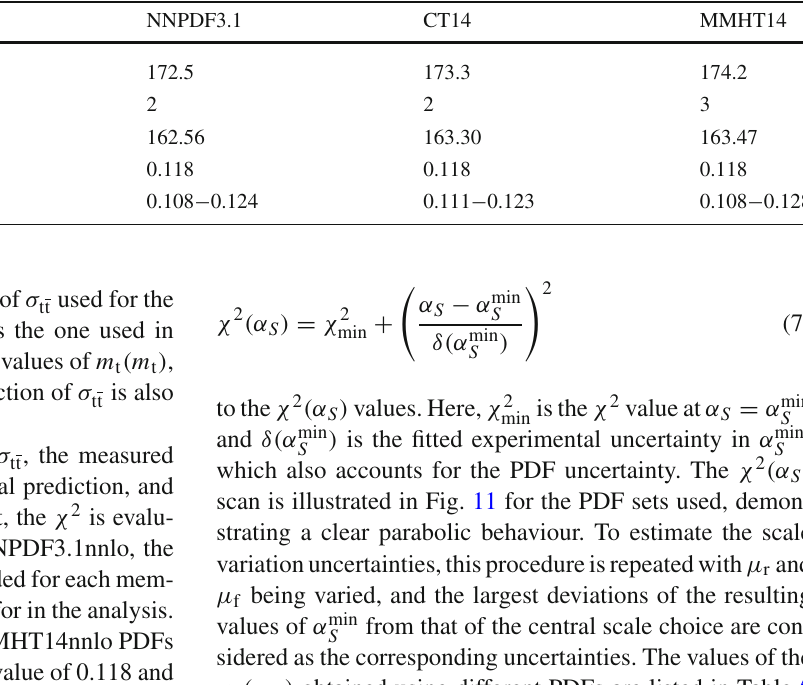
Table 4 Values of the top quark pole mass m pole version, the number of loops in the conversion, and the α S range used t and strong coupling constant α S ( m Z ) used in the different PDF sets. Also shown are the to estimate the PDF corresponding m t ( m t ) values obtained using the RunDec [83,84] con-